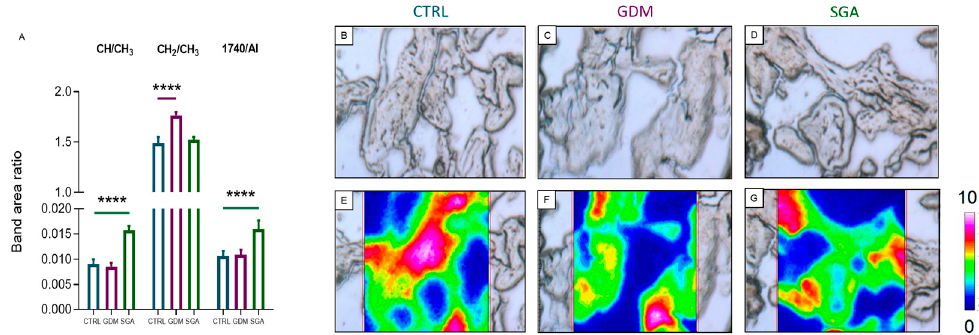
Figure 7. FTIRI analysis of the lipid content and peroxidation in CV sections of CTRL, GDM, and SGA experimental groups. ( A ) Statistical analysis of the following band area ratios: CH/CH 3 , unsaturation degree in lipid alkyl chains; CH 2 /CH 3 , length of lipid alkyl chains; 1740/AI, C=O ester moiety in lipid alkyl chains. Values are reported as mean ± SD of five independent samples (n = 5). Asterisks indicate significant differences between CTRL (blue) and GDM (purple) and CTRL and SGA (green) groups (****= p < 0.0001). ( B – D ) Microphotographs of representative sections of CTRL, GDM, and SGA experimental groups, and ( E – G ) corresponding false-color images showing the topographical distribution of lipids within the mapped areas; absorbances ranged from white/pink (representing the highest values) and blue/black (representing the lowest ones).